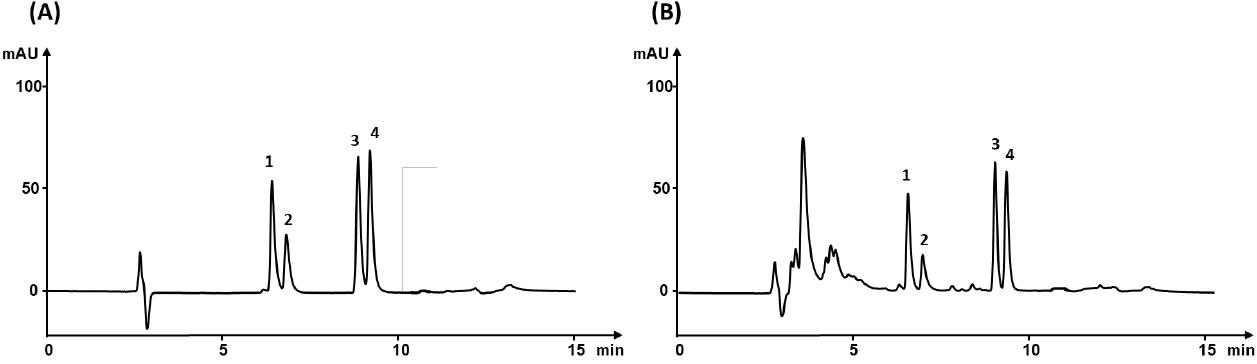
Figure 3. Chromatograms of ( A ) standard solution and ( B ) matrix solution spiked with 1000 ng mL − 1 NSAID at a wavelength 270 nm. 1—ketoprofen, 2—naproxen, 3—sodium diclofenac,